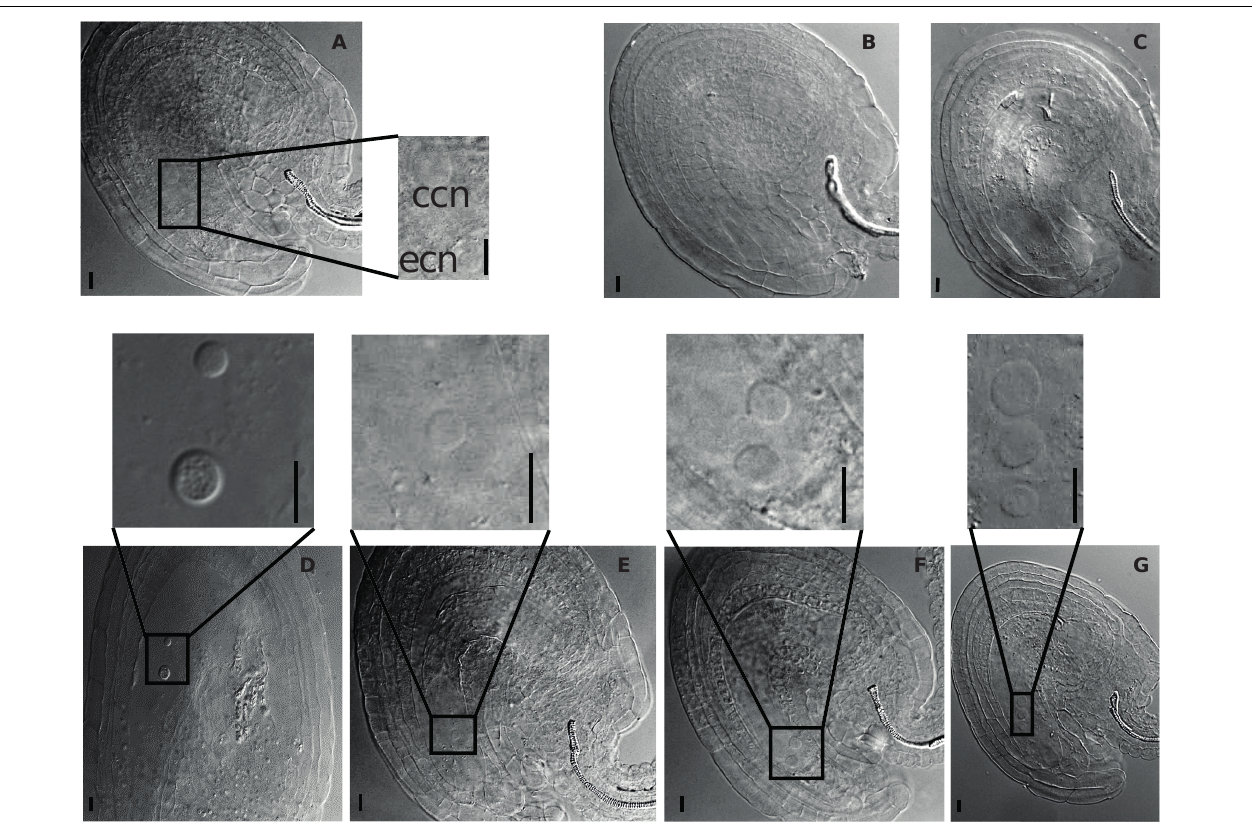
FIGURE 3 | Developmental defects in female gametophyte of tetraploid nse2-1 . Cleared ovules from 4x nse2-1 were observed under a differential interference contrast microscope. The nuclei are marked with dashed circles and arrows. Scale bars = 10 µ m. (A) A typical 4x WT-like embryo sac showing one egg cell nucleus (ecn) and one central cell nucleus (ccn). (B–G) 4x nse2-1 ovules displaying specific defects: (B) absence of embryo sac and (C) embryo sacs (C) without nuclei, (D) with two nuclei at the abnormal position, (E) only one nucleus, (F) two equally size nuclei, and (G) one smaller nucleus and two bigger nuclei.